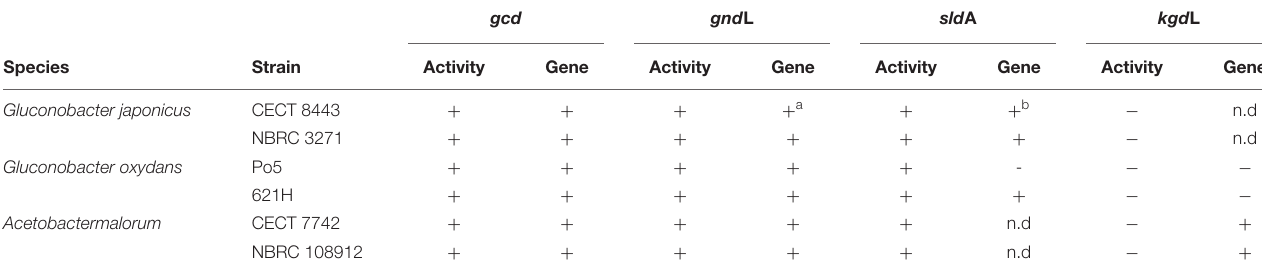
TABLE 3 | Results of PCR analyses of gcd, gnd L , sld A, and kgd L genes, and of enzyme activity for the six tested acetic acid bacteria